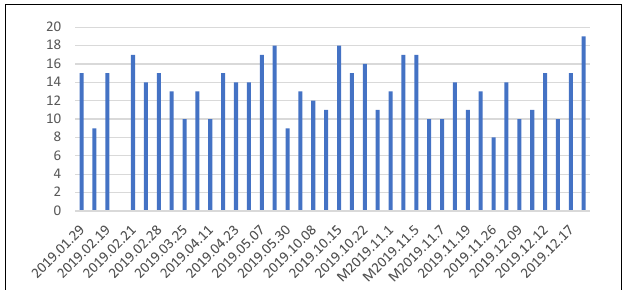
FIGURE 7 | Number of students participating in discourse and metadiscourse sessions.